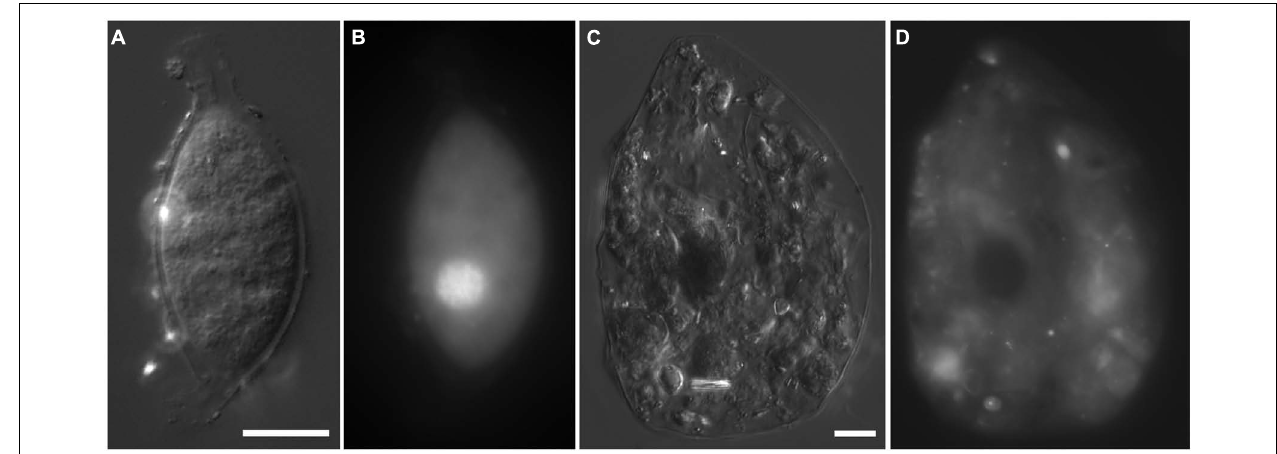
carcass from 609-610 cL (Discovery lower halocline), paired images showing DIC (C) and epifluorescence (D) of DAPI staining. Note the lack of a DAPI labeled nucleus and presence of a few prokaryotes. This specimen was considered dead at the time of fixation. Scales = 10 μ m.